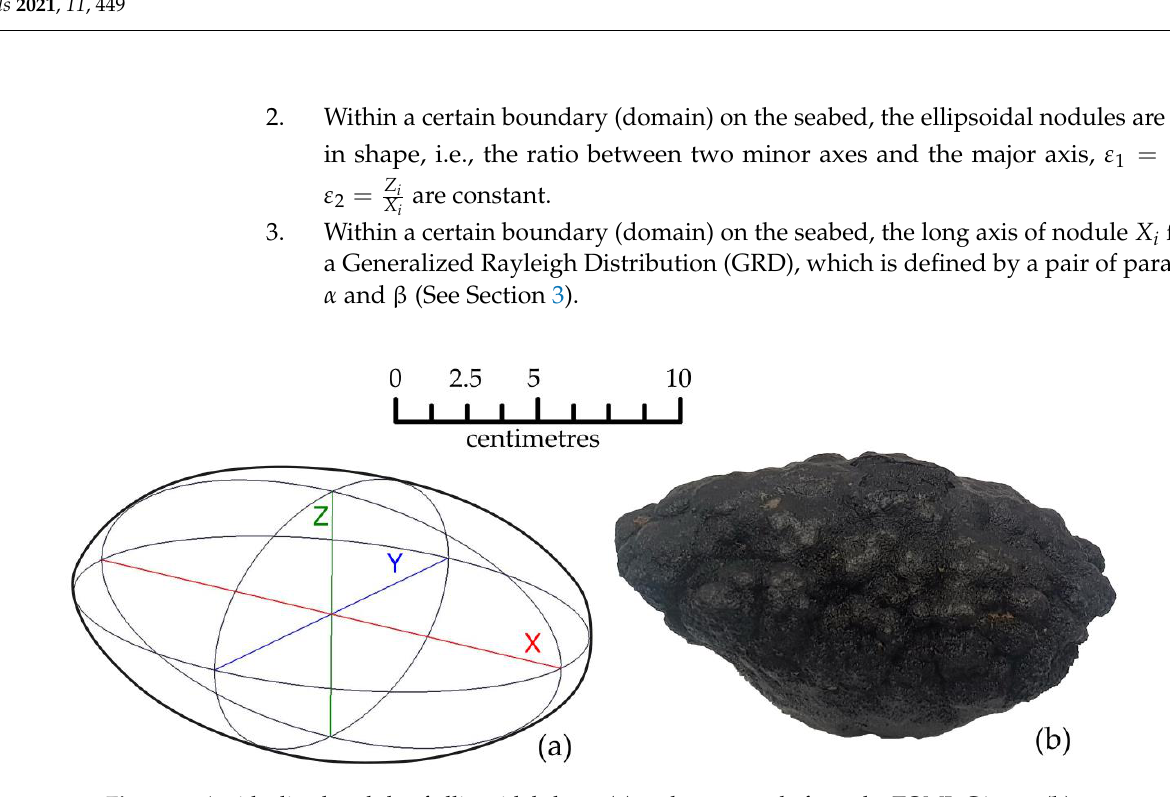
Figure 2 . An idealized nodule of ellipsoidal shape ( a ) and an example from the TOML C1 area ( b ).